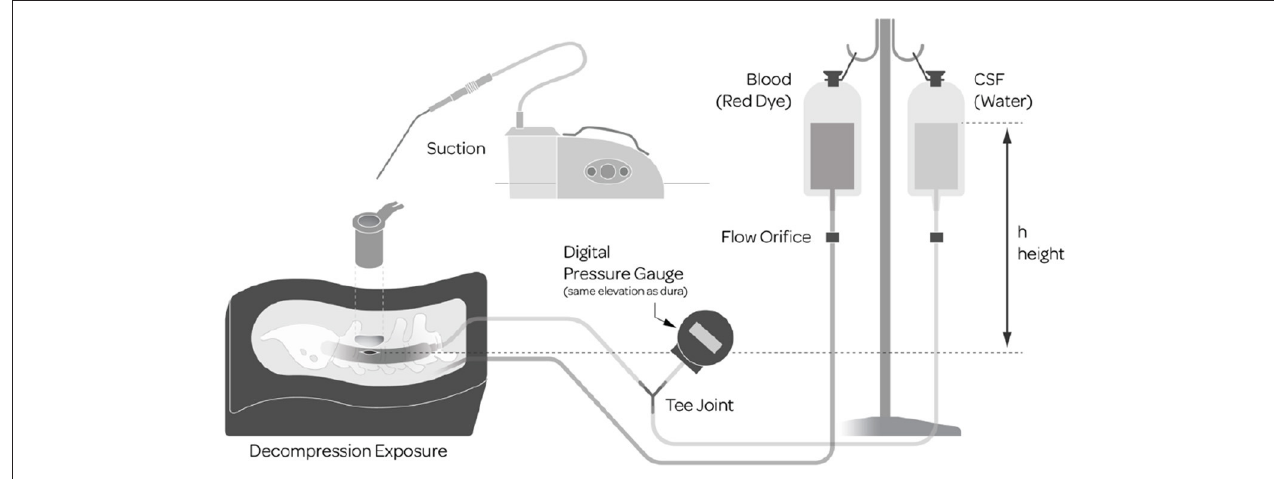
FIGURE 1 | Simulated durotomy model.